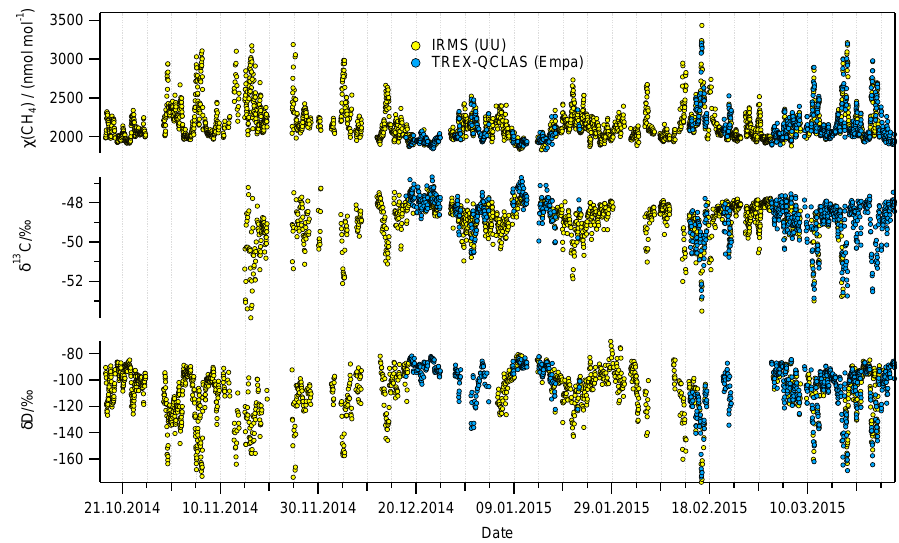
Figure 2. CH 4 mole fraction, χ (CH 4 ) and isotopic composition ( δ 13 C, δ D) measured at the Cabauw tall tower from 17 October 2014 until 29 March 2015. Real-time measurements by IRMS (Utrecht University) are indicated in yellow, and TREX-QCLAS (Empa) data in